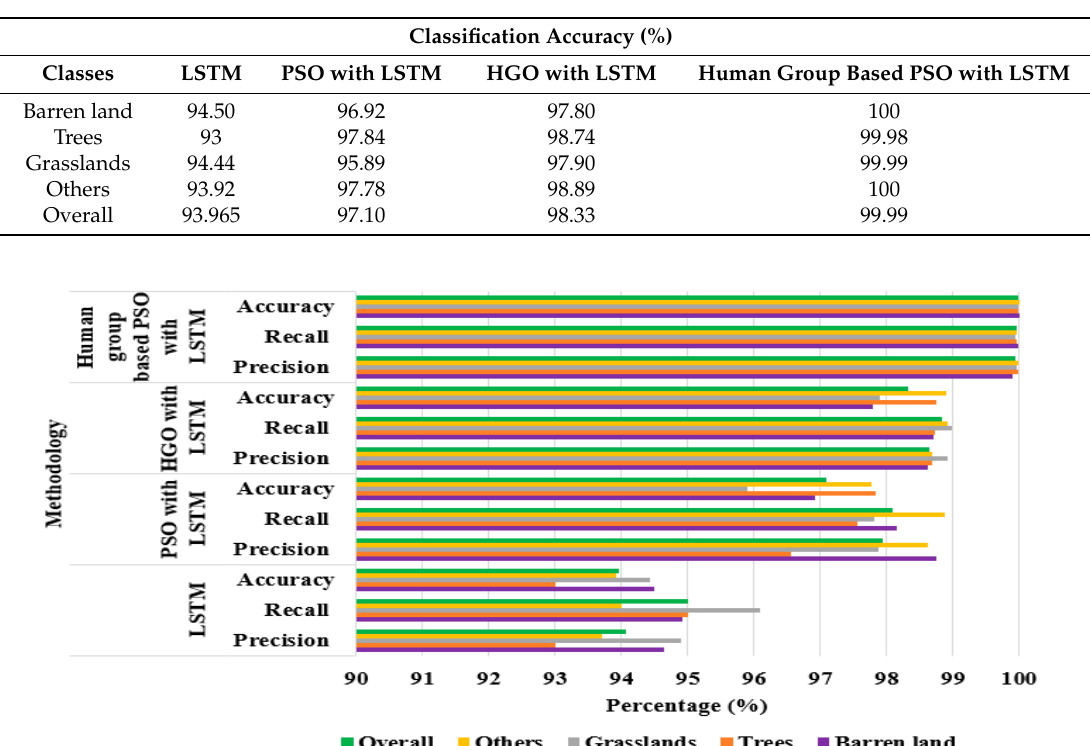
Figure 9. Graphical investigation of the proposed model with different optimization techniques on Sat 4 dataset.